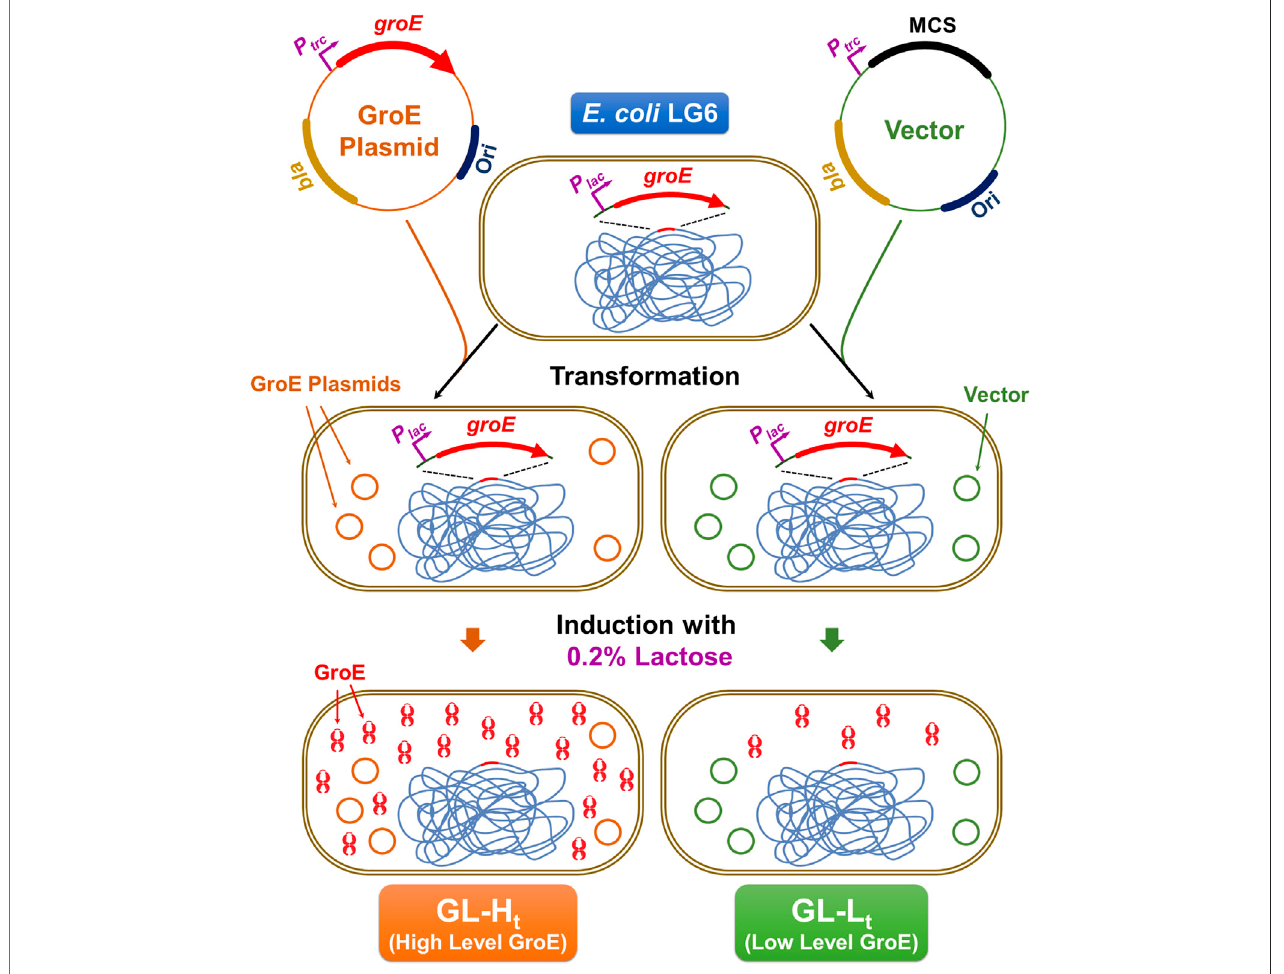
FIGURE1| ConstructionofGL-L t andGL-H t Strains.In E.coli LG6,the groE operonisunderthecontroloftheinducible P trc promoter.Thisstrainwastransformed with either a plasmid expressing groE under the control of lactose (GroE Plasmid), pTrc-GSL or its empty vector (Vector), pTrc99a. Upon culturing in the presence of lactose, GL-H t produces elevated levels of GroEL and GroES, due to the induction of chromosomal and plasmid-borne groE operon, while GL-L t will have lower production of GroES and GroEL due to the induction of only the chromosomal groE copy.